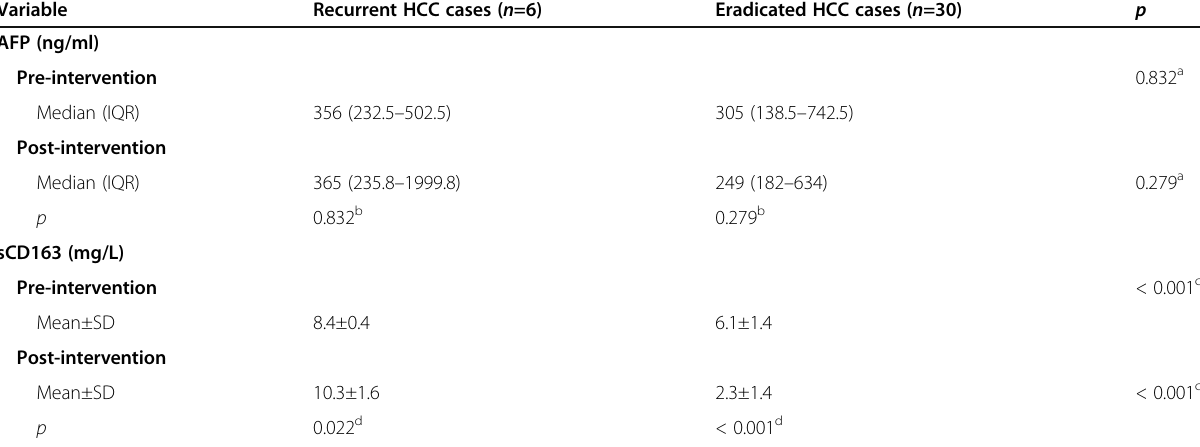
Table 5 AFP and sCD163 in recurrent and eradicated HCC cases pre- and post-locoregional intervention Variable